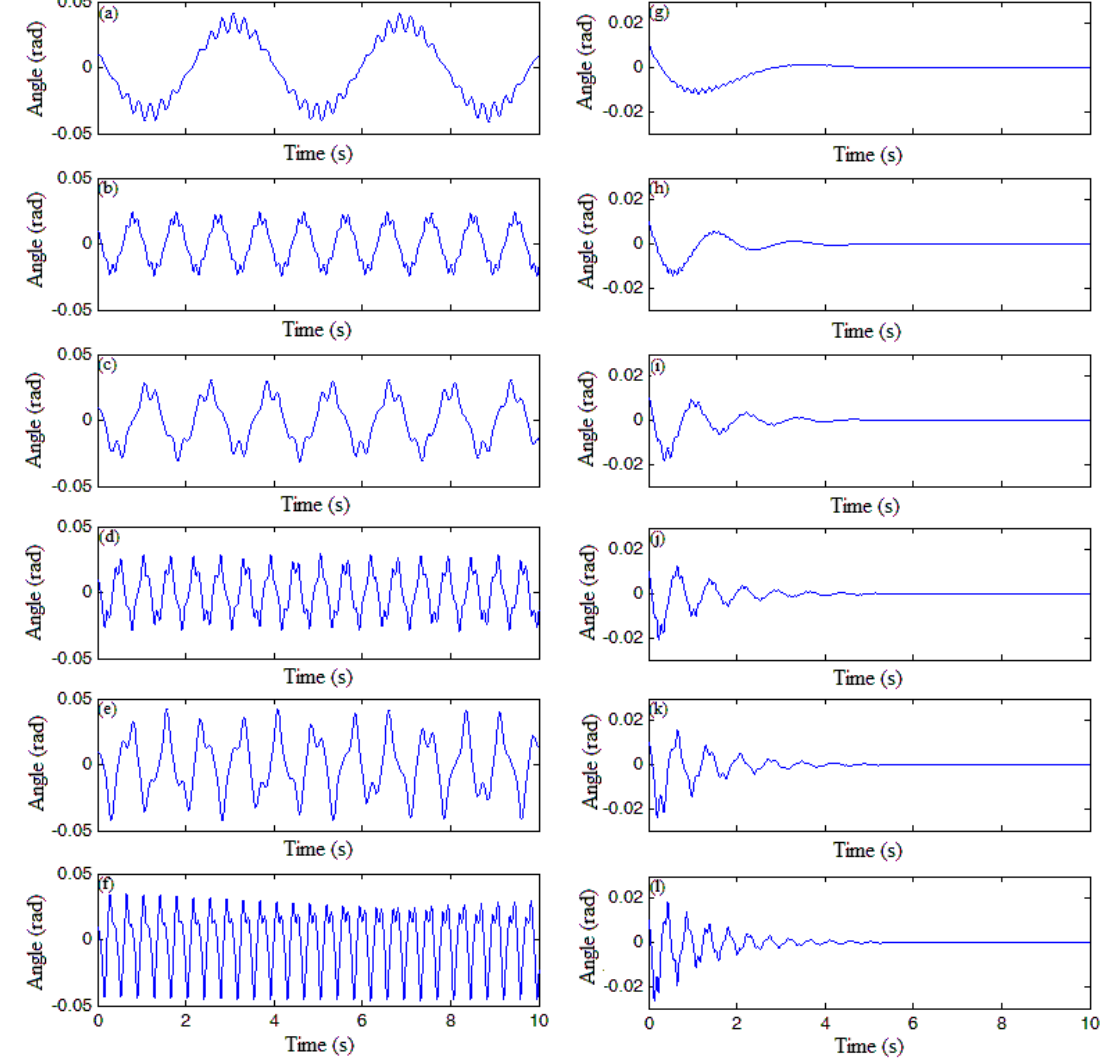
Figure 8. Time response of inverted pendulum systems in vacuum (( a ) ω = 25, μ = 0.02; ( b ) ω = 50, μ =